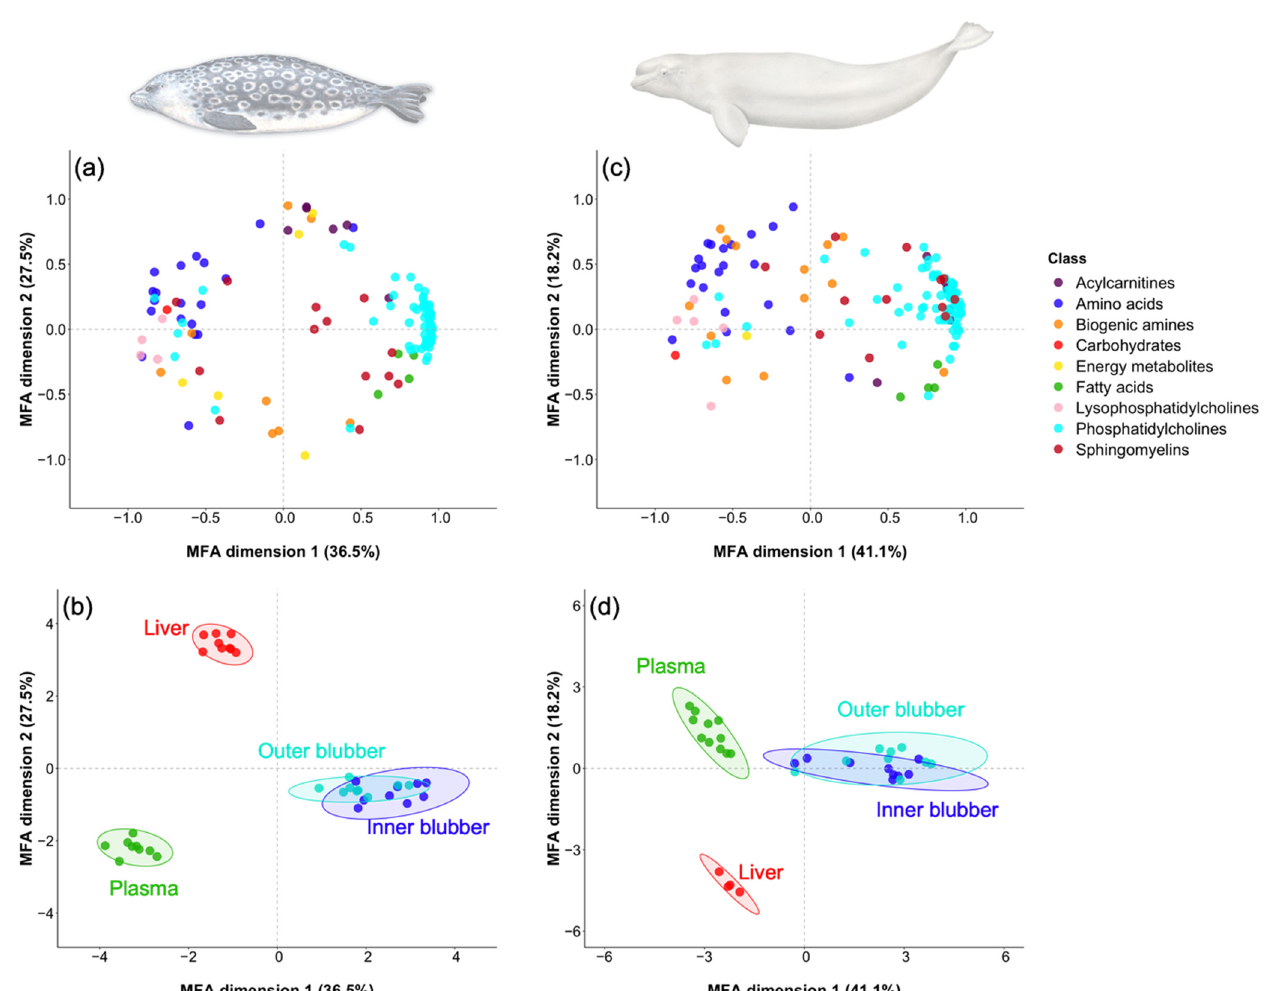
Figure 1. Inter-tissue metabolite patterns differed within each of the two marine mammals. Quan- titative variables ( a , c ) and individuals ( b , d ) of the multiple factor analysis (MFA) was performed with log-transformed percentages of metabolites quantified in plasma, liver, inner blubber and outer blubber of adult male ringed seals from Lake Melville ( a , b ) and Eastern Beaufort Sea belugas ( c , d ). Quantitative variables and individuals are colored by metabolite classes and tissue, respectively. For each species, only the metabolites that were detected in all tissues were used.